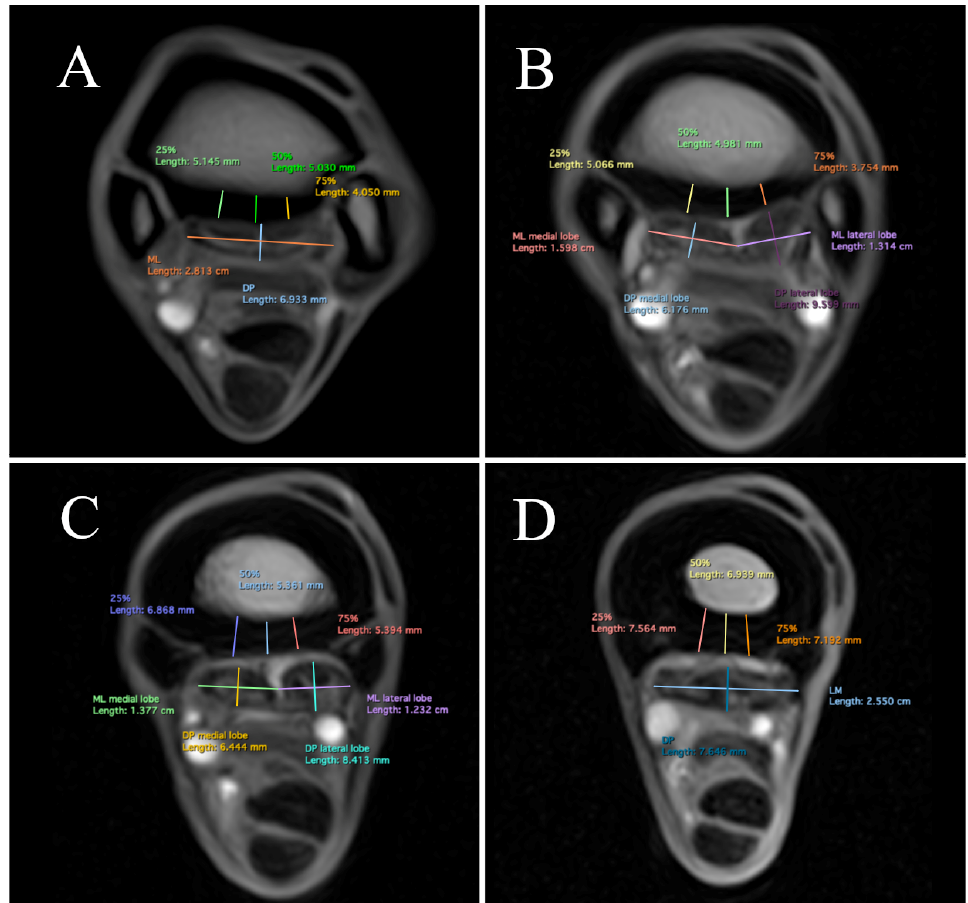
Figure 4. Transverse low-field T1-weighted gradient echo magnetic resonance images of an experi- enced endurance horse were obtained at 2 cm ( A ), 3 cm ( B ), 5 cm ( C ), and 7 cm ( D ) distal to the carpometacarpal joint. Medial is to the left and dorsal is to the top. (ML) mediolateral width; (DP) dorsopalmar depth; and (25, 50, 75%) palmar cortical thickness from medial to lateral. Table 4. Results of the pre-season (1st examination) and post-season (2nd examination) pooled data analysis for 12 endurance horses examined at an interval of approximately six months, using the paired samples t -test or the Wilcoxon signed-rank test for the comparison of the mediolateral (ML) width and dorsopalmar depth (DP) of the suspensory ligament (SL) and its lobFes (top) and medial and lateral lobes of the SL, at 2, 3, 5, and 7 cm distal to the carpometacarpal joint (CMCJ); NNDD— not normally distributed data; SD—standard deviation; MD—mean difference; CI—confidence in- tervals. * = statistically significant, p < 0.05. SL ML Width—DP Depth Level